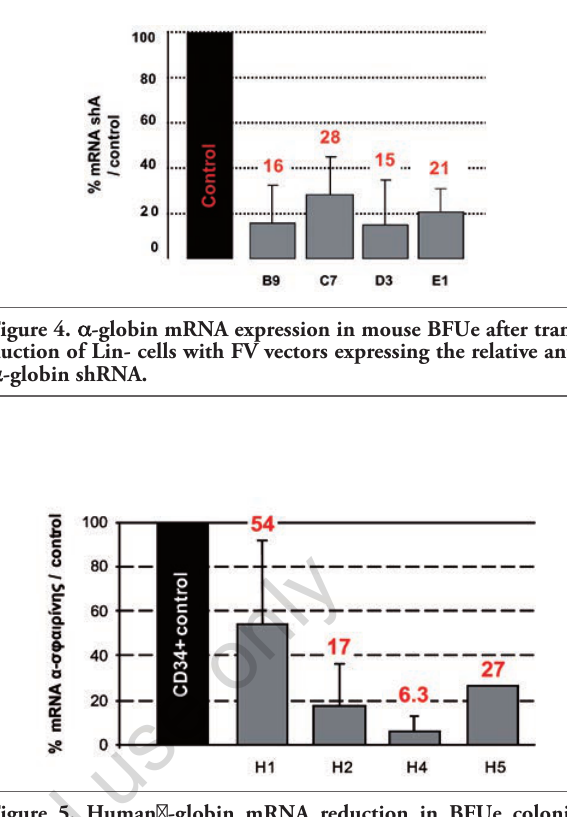
Figure 5. Human(cid:0)-globin mRNA reduction in BFUe colonies derived from CD34+ cells using 4 different shRNA expressed from foamy virus vectors.